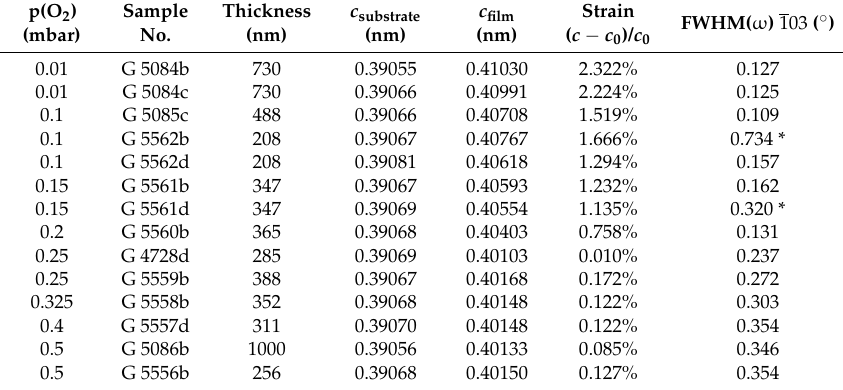
Table 1. X-ray diffraction (XRD) lattice parameters of SrTiO 3 substrates and BaTiO 3 -BiFeO 3 composite films on SrTiO 3 :Nb(001) at the indicated growth pressures p(O 2 ). Composite film thickness